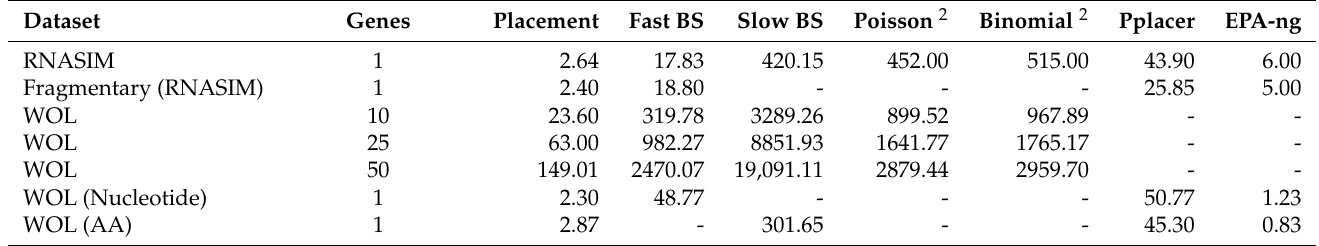
Table 1. Time taken (in seconds 1 ) to place 200 queries (RNASIM) and 1000 queries (WOL) and to find their support values from 100 replicates using different support estimation